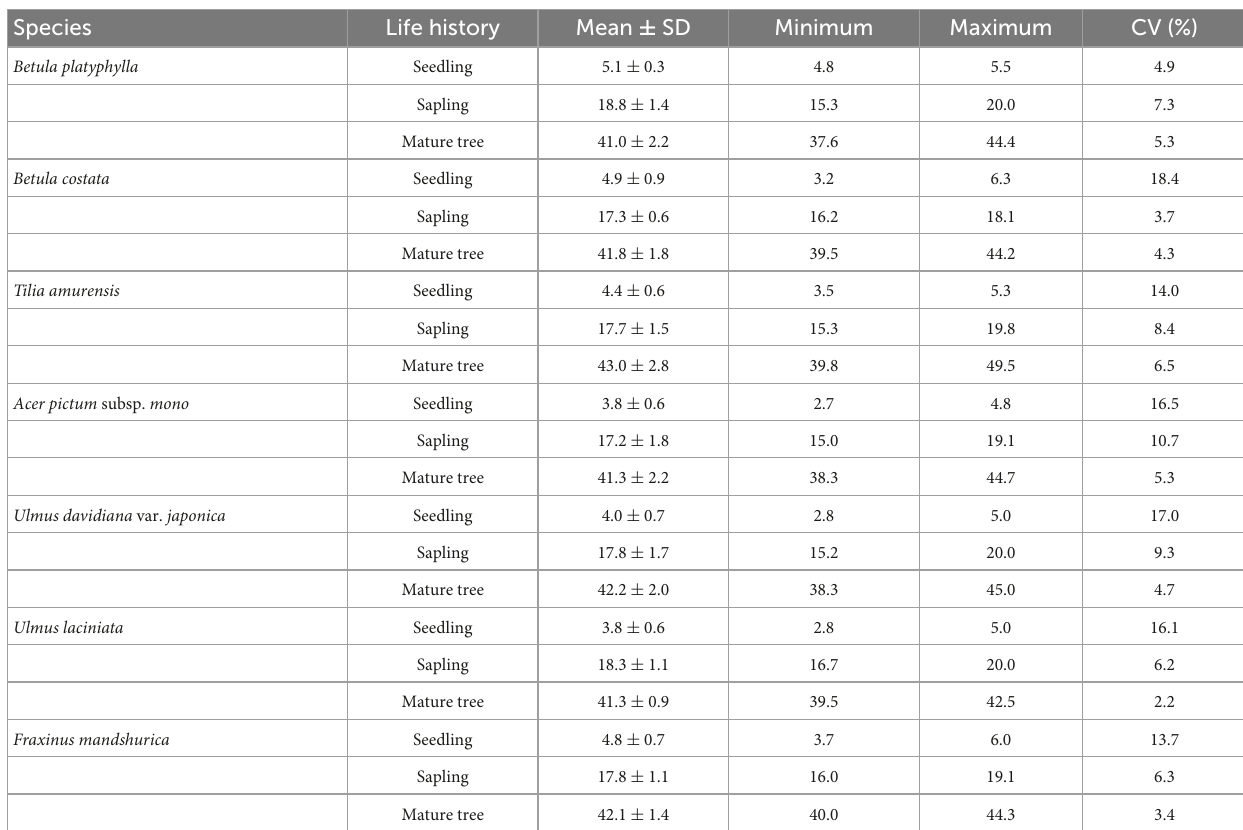
TABLE 1 Statistical information of diameter at breast height (DBH)